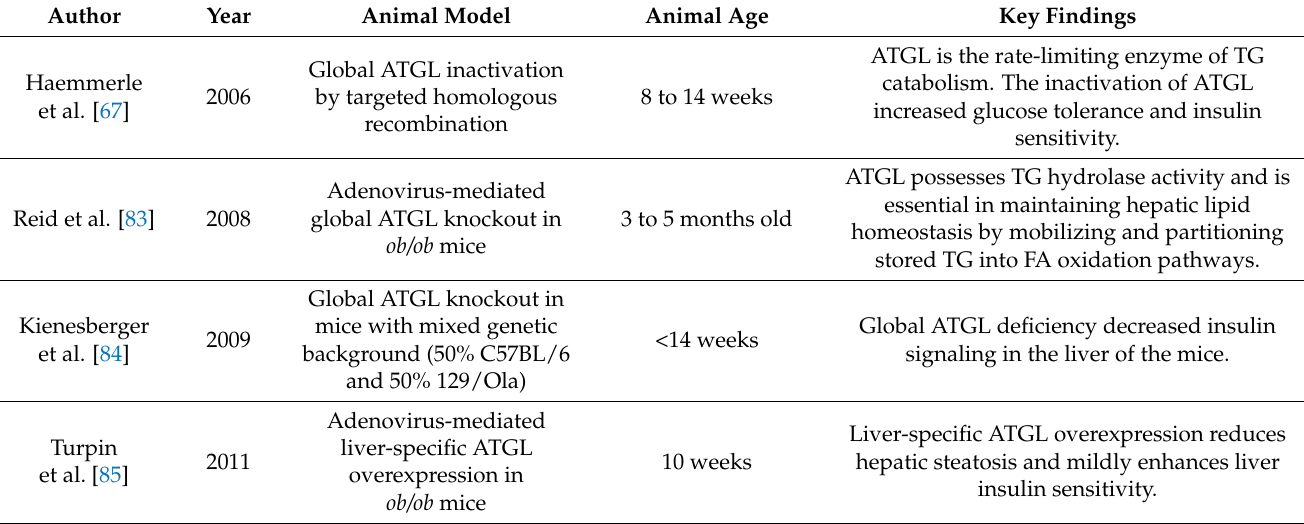
Table 1. Studies of mouse models with global- and liver-specific mutation of